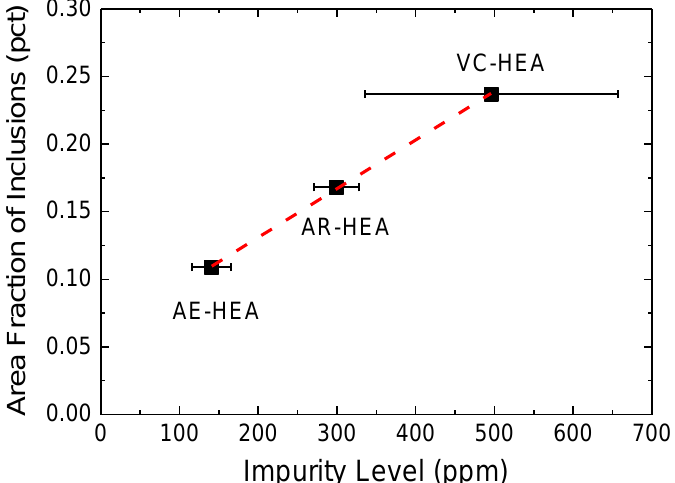
Figure 6. Comparison of area fraction of inclusions for the high-entropy alloys (HEAs) according to impurity level (IL) (IL = Al + S + O).